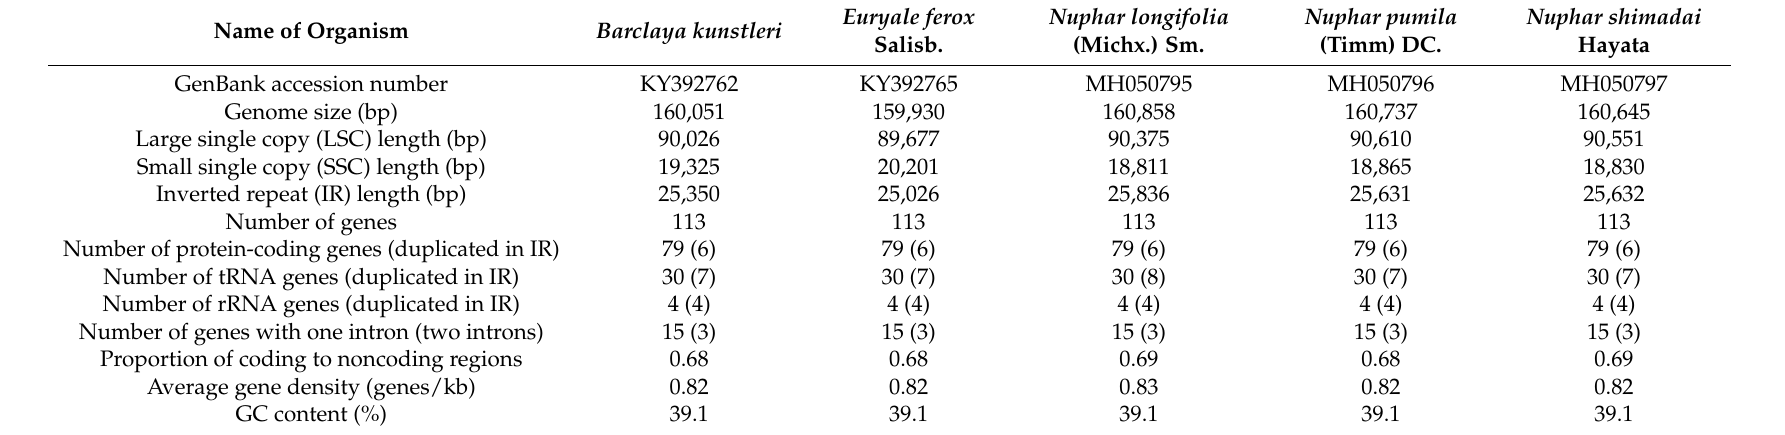
Table 1. Characteristics of chloroplast genomes of five species of